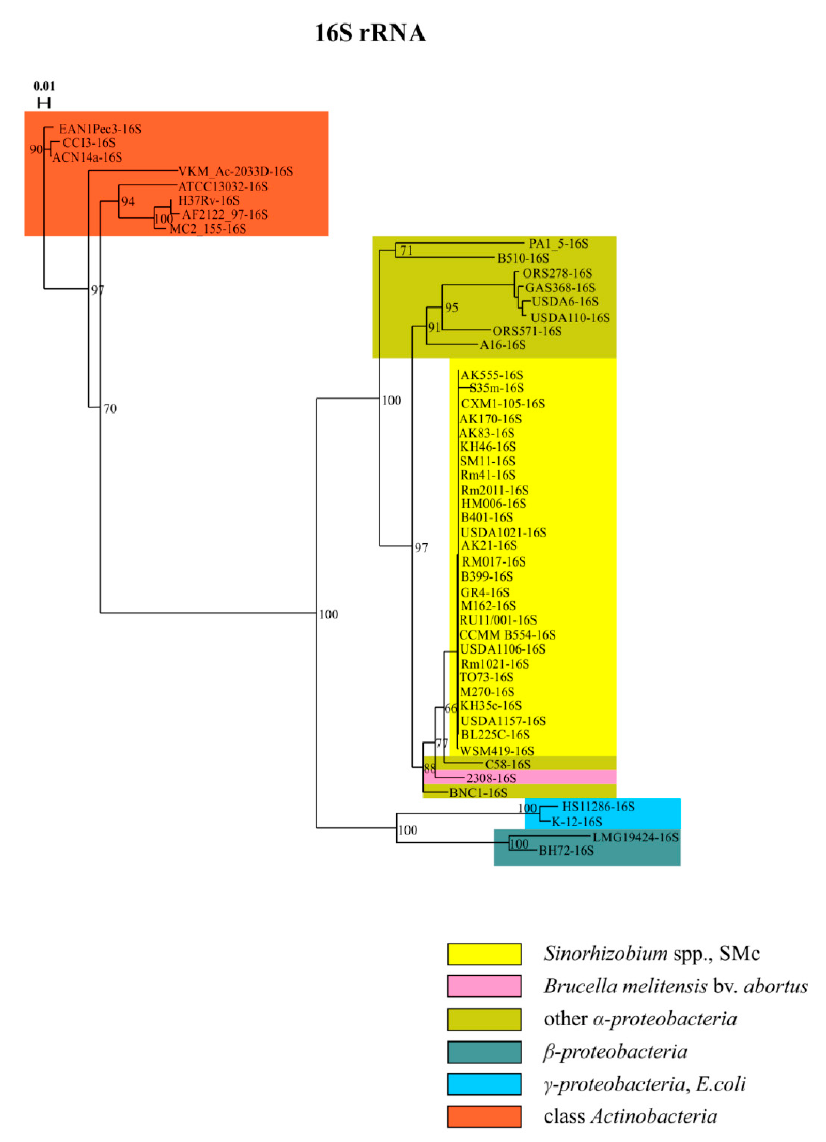
Figure 3. Phylogenetic analysis of 16S rRNA gene sequences in α -, β - and γ -proteobacteria, as well as Actinobacteria . The nucleotide substitution model selected for the analysis was TVM + F + G4 for 16S rRNA. The scale bar was 0.01 for 16S rRNA nucleotide substitutions per site.